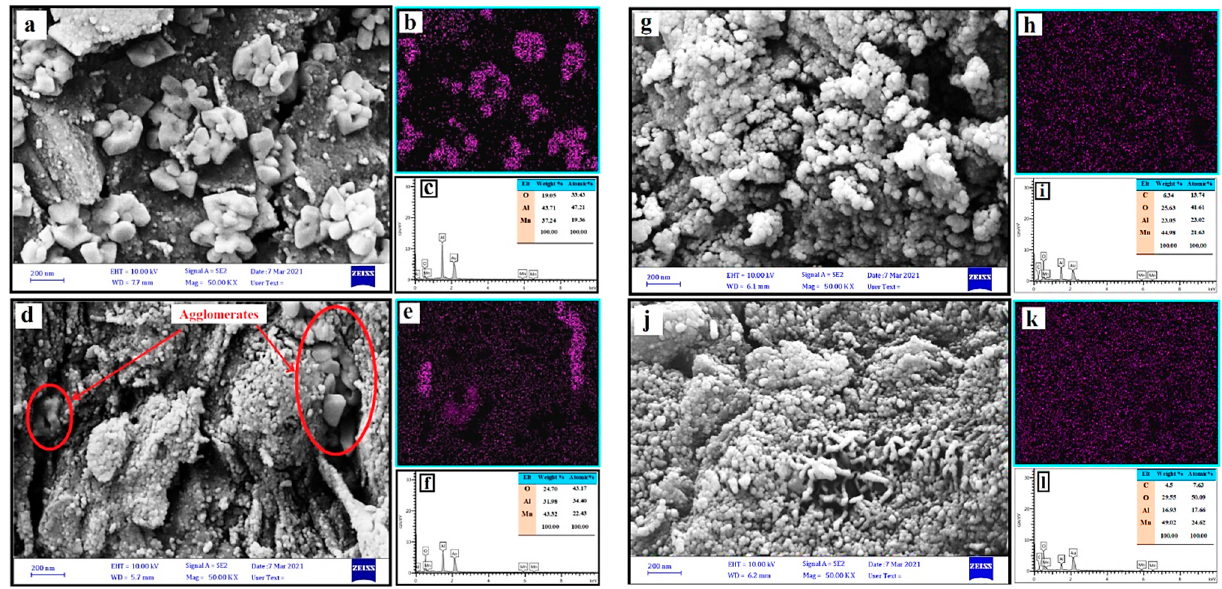
Figure 2. SEM images, manganese mapping FESEM analyses and EDX patterns of the Mn/Al ( a – c ), Mn-Acac air /Al ( d – f ), Mn-Acac arg /Al ( g – i ) and the Mn-BTC arg /Al ( j – l ) samples.